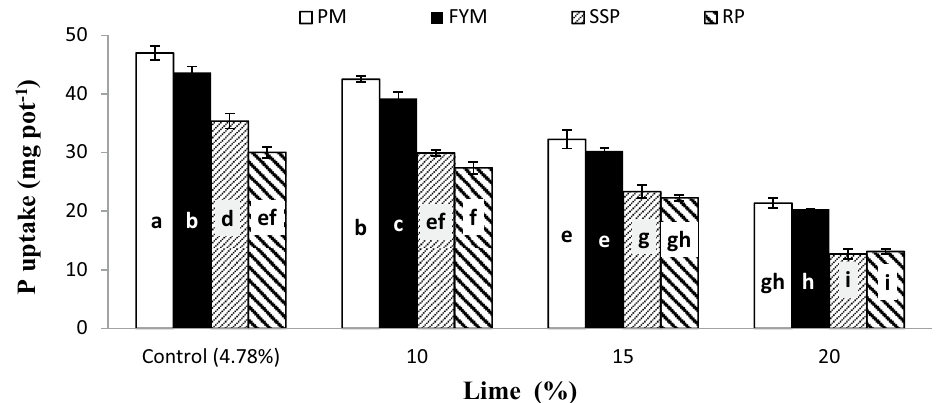
Figure 11. Plant P uptake (mg kg −1 ) as affected by the interaction of P sources and Lime. Graph bars having different letters are significantly different at α = 0.05. Errors bar represent standard error for the mean of three